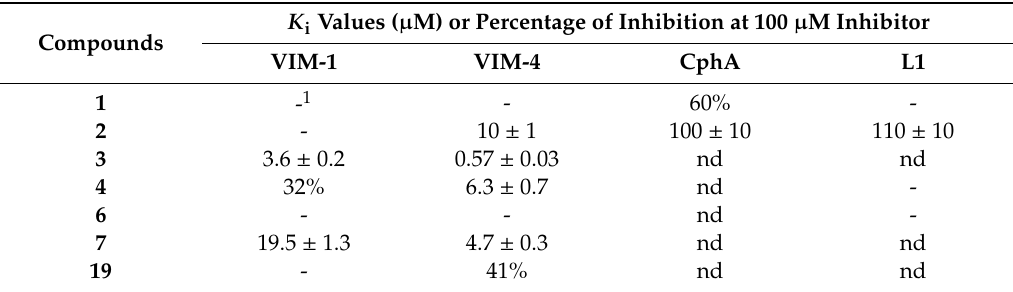
Table 3. Inhibitory potencies of compounds 1 – 4 , 6 , 7 , and 19 against additional MBLs. Compounds